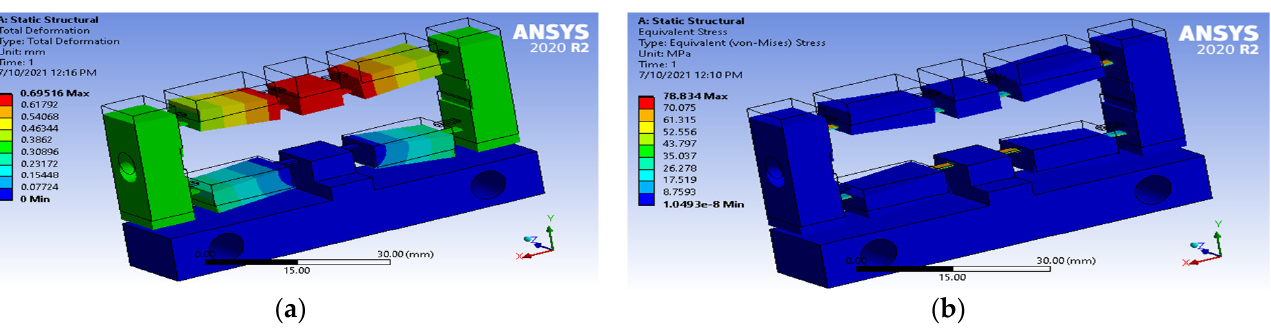
Figure 9. The optimal results. ( a ) The optimal result of displacement; ( b ) The optimal result of